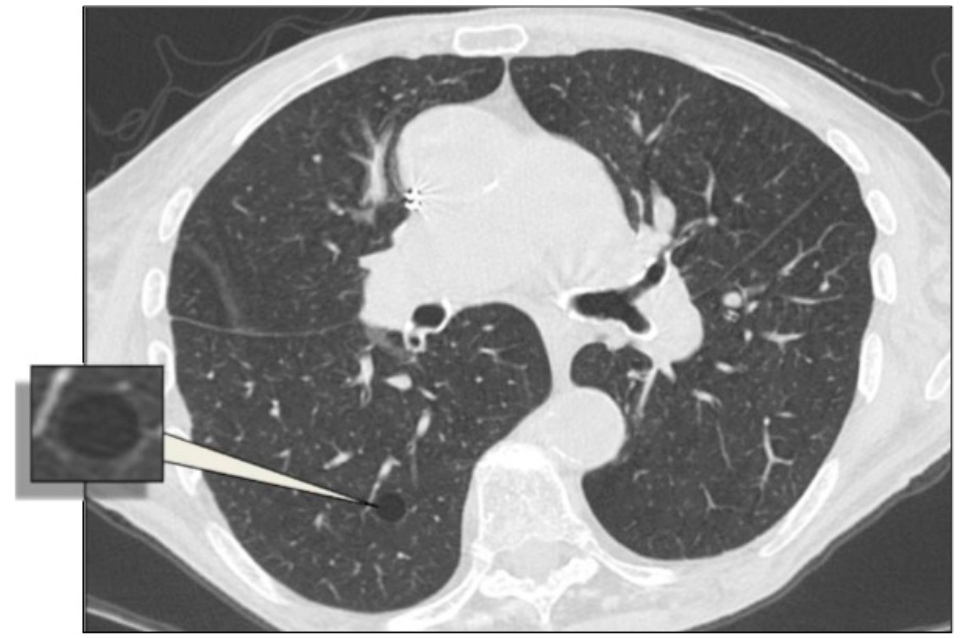
Figure 19. Aging lung manifests with the progressive air space enlargement. These cysts are thin-walled, and have a wide distribution. This figure has been partially modified from ECR 2017/C-2141 Cystic pattern in lung diseases: a simplified HRCT guide based on free-hand drawings, DC Caltabiano, V. Costanzo, L. Mammino, V. Vindigni, S. Torrisi, R. Rosso, LA Mauro, C. Vancheri, S. Palmucci.